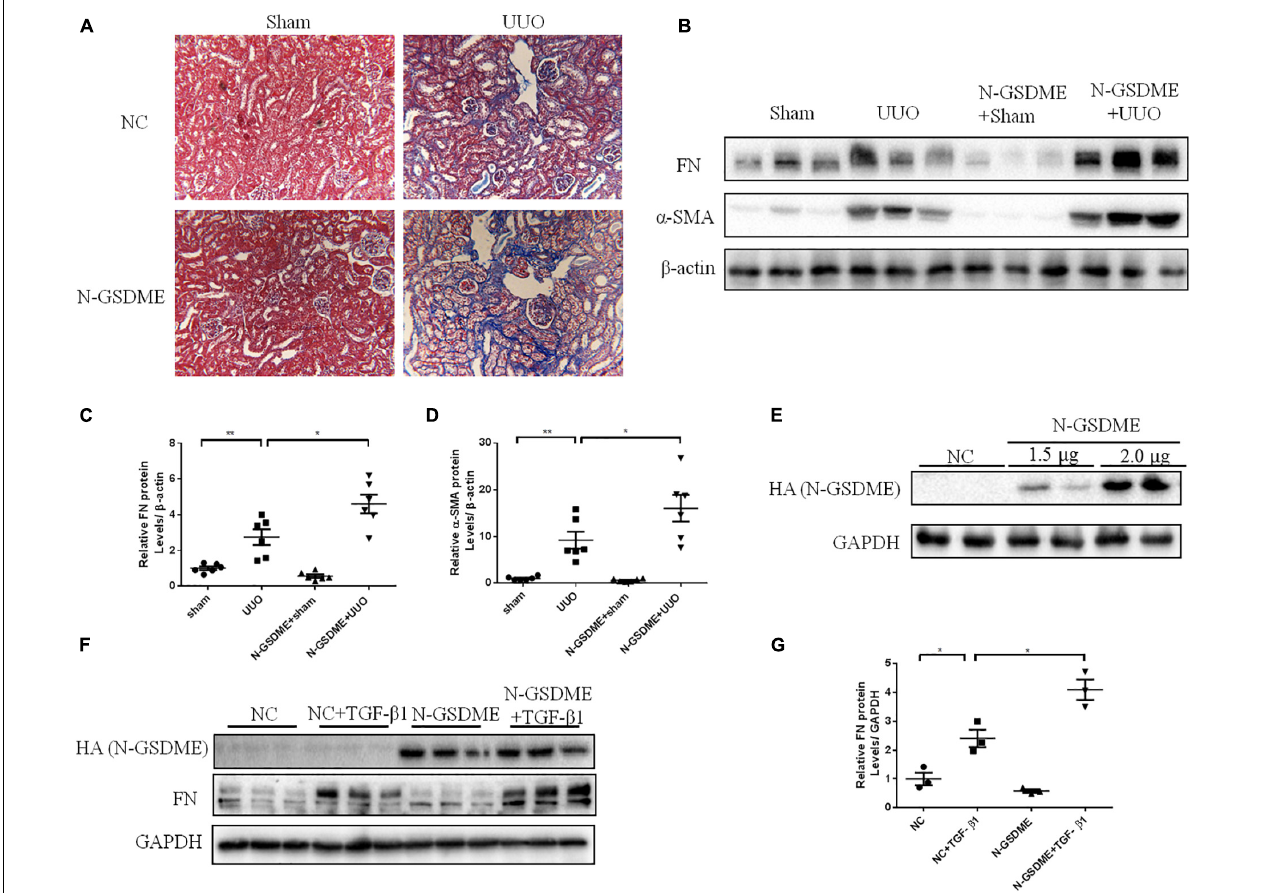
FIGURE 4 | N-GSDME-induced pyroptosis exacerbates renal fibrosis in UUO mice and TGF- β 1-treated renal tubular epithelial cells. Mice treated with N-GSDME overexpressing plasmid by tail vein injection and HK-2 cells treated with N-GSDME were used to determine the effect of N-GSDME in renal fibrosis. (A) Masson staining of kidney sections of N-GSDME overexpressing UUO mice (200 × ). (B–D) Western blotting analysis of FN and α -SMA in mouse kidneys from different groups ( n = 6). (E) Transfection efficiency of N-GSDME overexpressing plasmid at a dosage of 0, 1.5, and 2 µ g/mL detected by Western blotting analysis. (F,G) Western blotting analysis of FN in cells transfected with N-GSDME plasmids (2 µ g/mL) followed by treatment with TGF- β 1 (10 ng/mL), n = 3 in each group. For the cell experiments, three independent experiments were performed. The quantitative results were shown as the means ± SEM.* p < 0.05; ** p < 0.01.